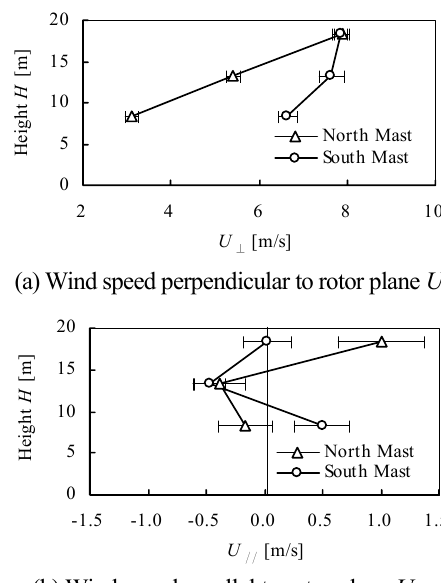
Fig.7 Wind speed profiles at σ